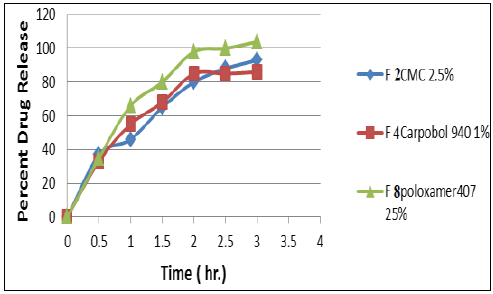
Figure 4: Effect of different polymers on the clotrimazole release from different formulas. Table (7) Mathematical finding of clotrimazole release from repared gels. Formula